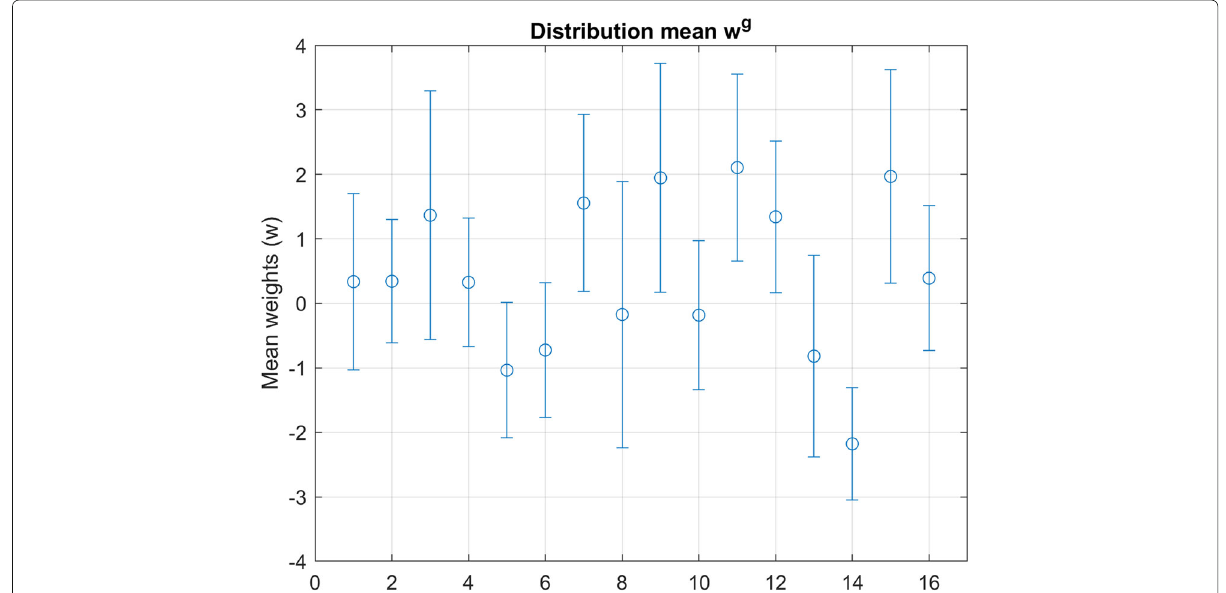
Fig. 7 Generated Distribution Mean: Mean values of the principle vector w used to synthesize more general